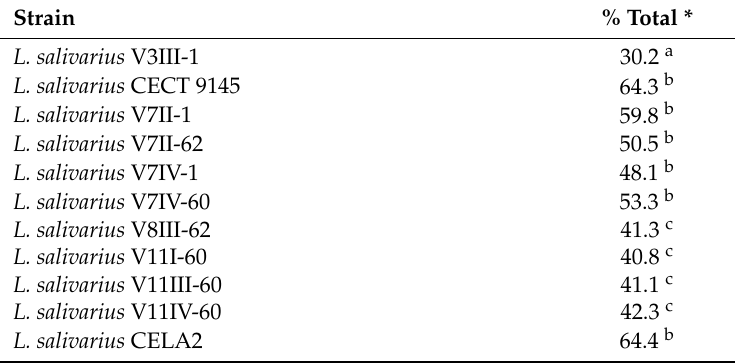
Table 3. The percentage (%) of initial lactobacilli (9 log 10 cfu/mL) that survived to conditions simulating those of the gastrointestinal